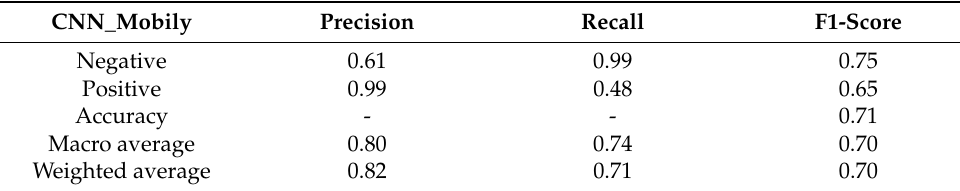
Table 5. Confusion Matrix obtained by CNN on the Mobily dataset.